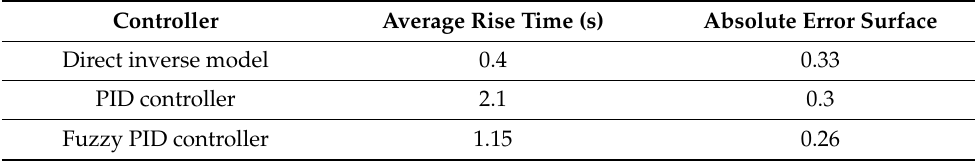
Figure 15. Performance of the controllers on a test bench. Table 3. Performance of the controllers on the test bench with fuel